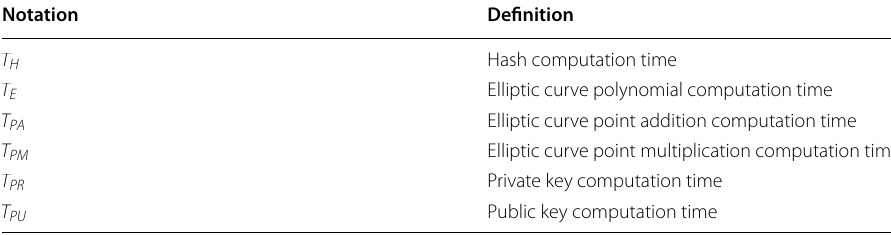
Table 6 Definition of some notations used in performance evaluation of the proposed scheme